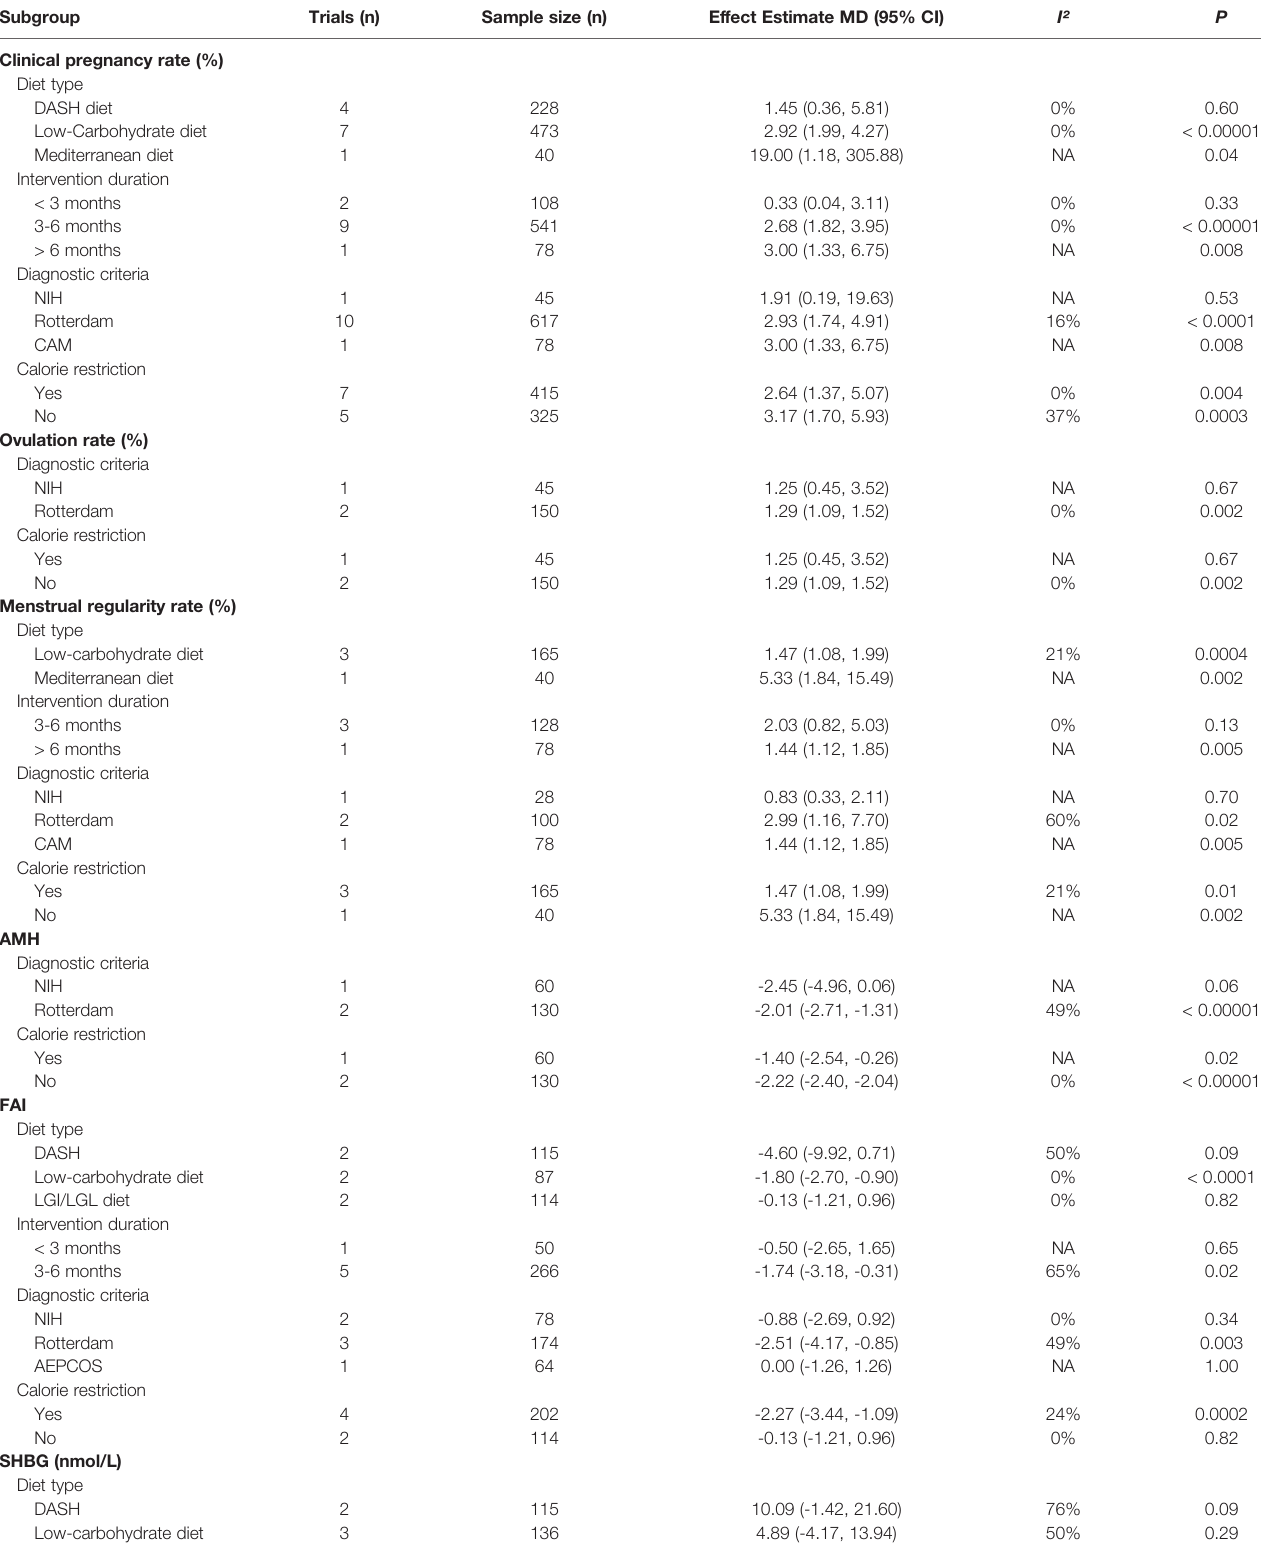
TABLE 2 | Effect estimates and heterogeneity of subgroup analysis for outcomes.